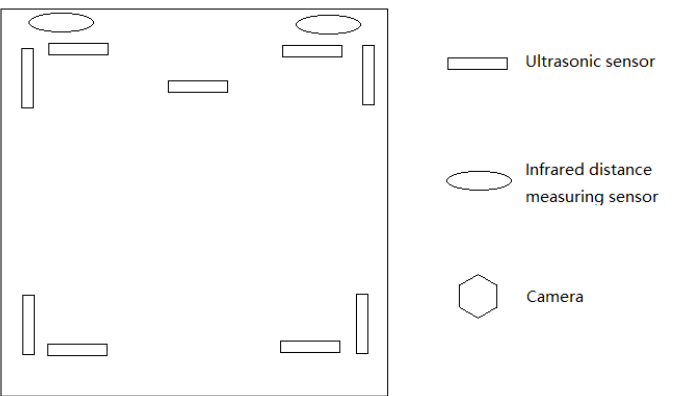
Figure 3. Sensor Layout.